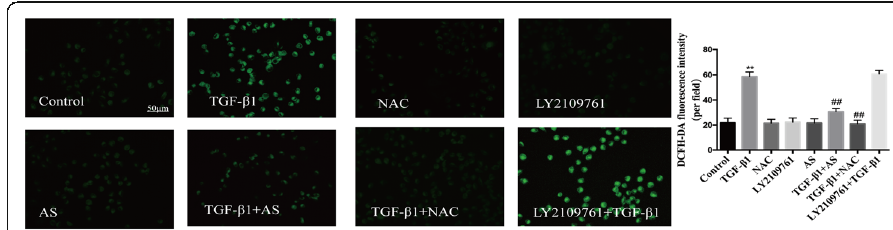
Fig. 5 Effect of asiaticoside on reactive oxygen species (ROS) production in TGF- β 1-treated HPMCs. Notes: HPMCs were divided into a vehicle group, an asiaticoside group (treated with 150 μ M asiaticoside), a TGF- β 1 group (treated with 10 ng/cm 3 TGF- β 1), a TGF- β 1 + asiaticoside group (treated with 150 μ M asiaticoside + 10 ng/cm 3 TGF- β 1), an NAC group (treated with 5 mM NAC), an NAC + TGF- β 1 group (pretreated with NAC at 5 mM 2 h prior to 10 ng/cm 3 TGF- β 1), a LY2109761 group (treated with 4 μ M LY2109761), and a LY2109761+ TGF- β 1 group (pretreated with LY2109761 at 4 μ M 1 h prior to 10 ng/cm 3 TGF- β 1). After incubation for 24 h, DCFH-DA fluorescence in cultured cells was analyzed by fluorescence microscopy (scale bar = 50 μ m). Quantitative measurements of the fluorescence intensities were conducted using ImageJ software. Abbreviations: AS, asiaticoside; TGF- β 1, transforming growth factor- β 1; DCFH-DA, 2 ′ ,7 ′ - dichlorodihydrofluorescein diacetate; NAC, n-acetylcysteine; LY2109761, TGF- β receptor kinase